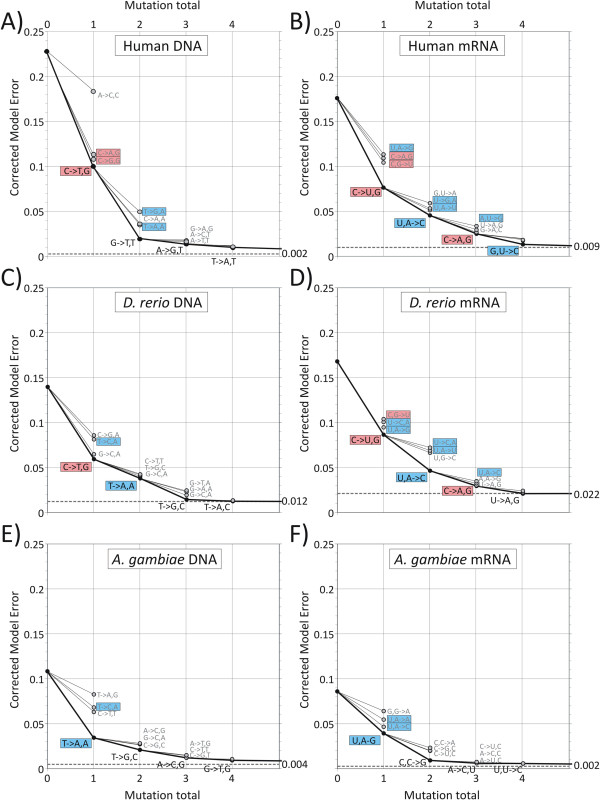
Model errors (y-axis) for mutational models with between 1 to 4 context-dependent mutational biases for vertebrate (human, D. rerio ) and non-vertebrate ( A. gambiae ) DNA and mRNA sequences. Minimum RMS distances for up to 16 additional mutational biases are shown as a dotted line. Model error reductions for alternative mutational biases are shown as unfilled circles. Mutations that remove CpG and T/UpA are shown in pink and blue inset boxes respectively. All model error values have been baseline corrected by subtraction of RMS scores of quadratic lines of best fit through observational data.